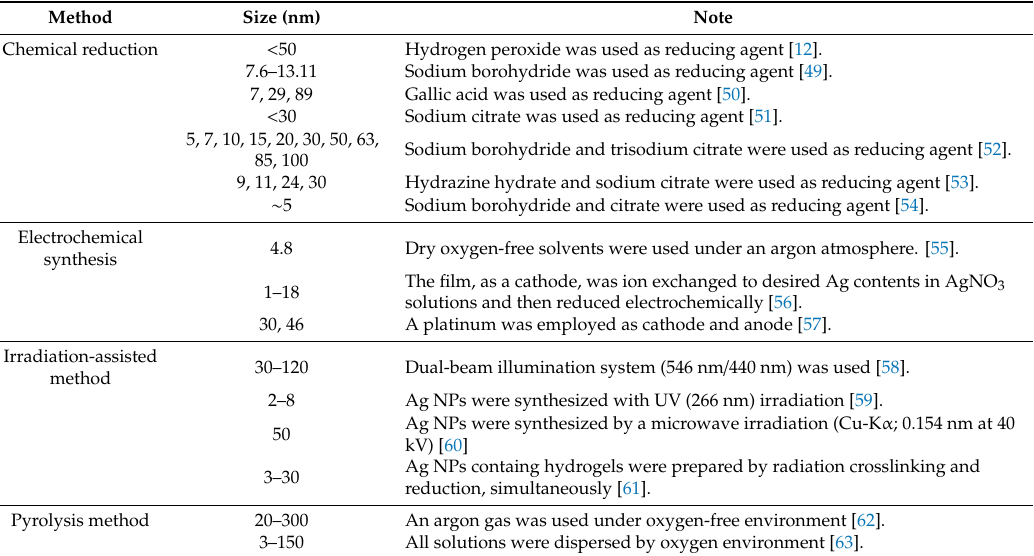
Table 2. Some chemical methods for synthesizing Ag